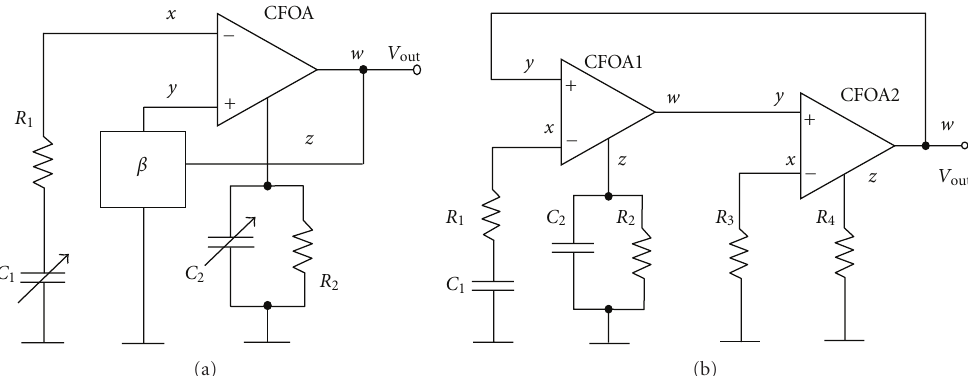
Figure 4: Enhanced oscillation systems with CFOA: (a) simplified, with feedback circuit β ; (b) fundamental, with two CFOA, one of which is used as circuit β .